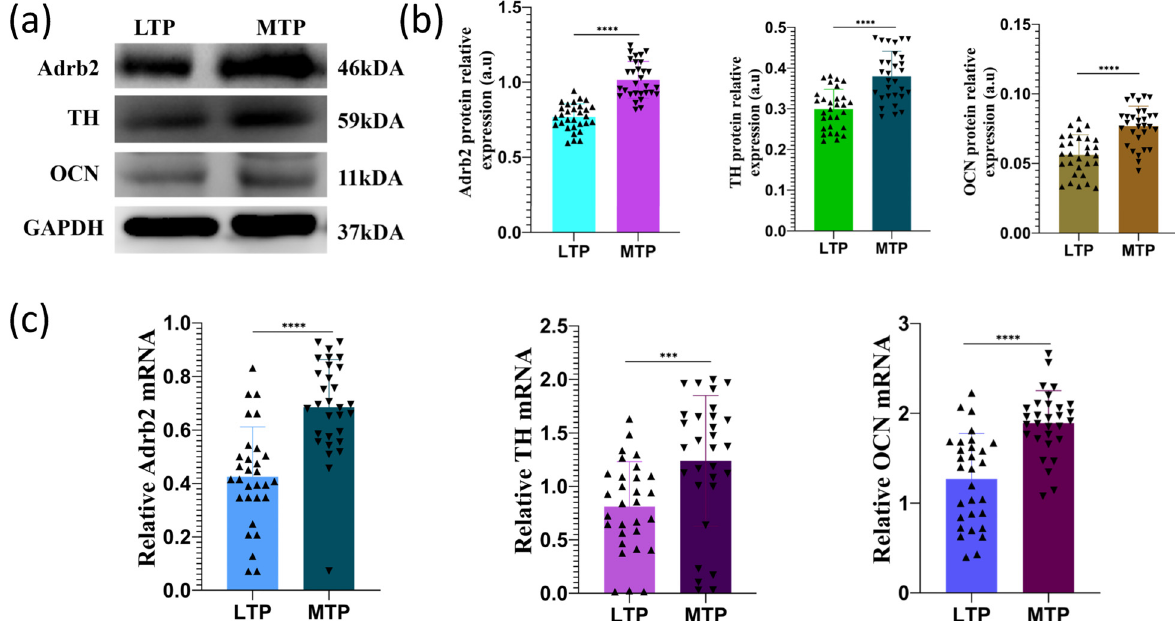
Figure 7: The expression levels of Adrb2, TH, and OCN in the subchondral bone of MTP and LTP. ( a ) Representative Western blots showing the expression of Adrb2, TH, and OCN. ( b ) Relative expression of Adrb2, TH, and OCN protein levels in the subchondral bone of MTP and LTP of knee osteoarthritis. GAPDH was used for normalization. ( c ) Semiquantitative reverse transcription PCR analysis of Adrb2, TH, and OCN in MTP and LTP subchondral bone in knee osteoarthritis. *** P < 0.001, **** P <